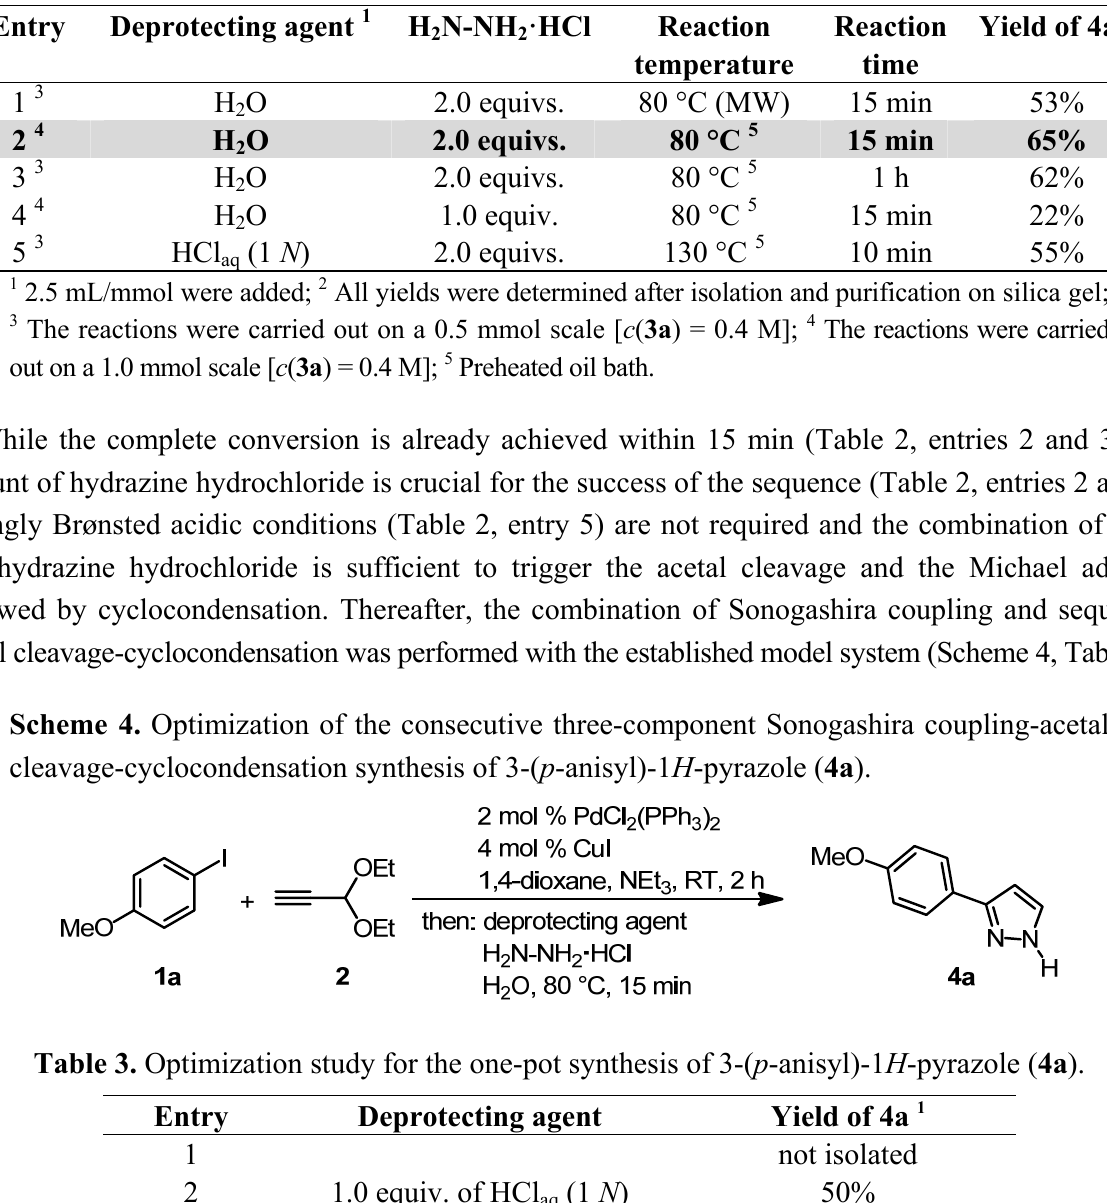
Table 2. Optimization study for the synthesis of 3-( p -anisyl)-1 H -pyrazole ( 4a ).